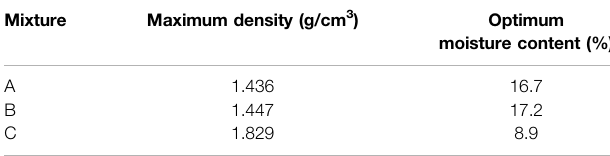
TABLE 5 | Maximum dry density and optimum water content of the mixture.